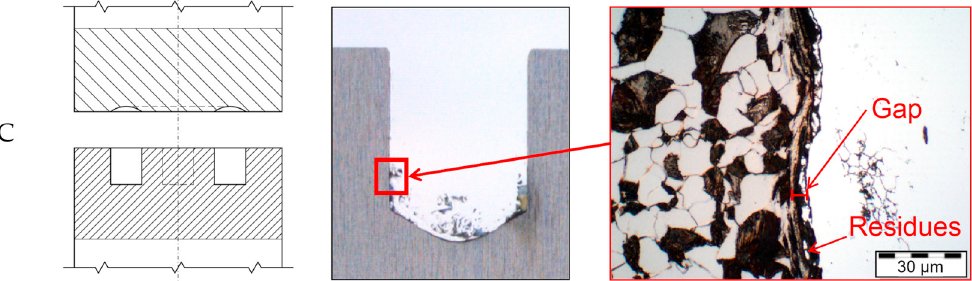
Figure 8. Geometry C, ( left ) schematic draft, ( middle ) overview of a filled borehole, and ( right ) exemplary gap at the borehole flank.